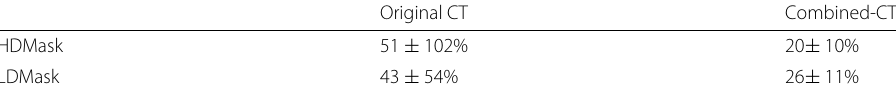
Table 3 Average ± standard deviation of the percentage differences between the compartment model and Patlak-Rutland analysis derived K i estimates using the reconstructions with the actual acquired CTs (original CT) and using the reconstructions with the combined-CTs Original CT Combined-CT HDMask 51 ± 102% 20 ± 10% LDMask 43 ± 54% 26 ± 11%